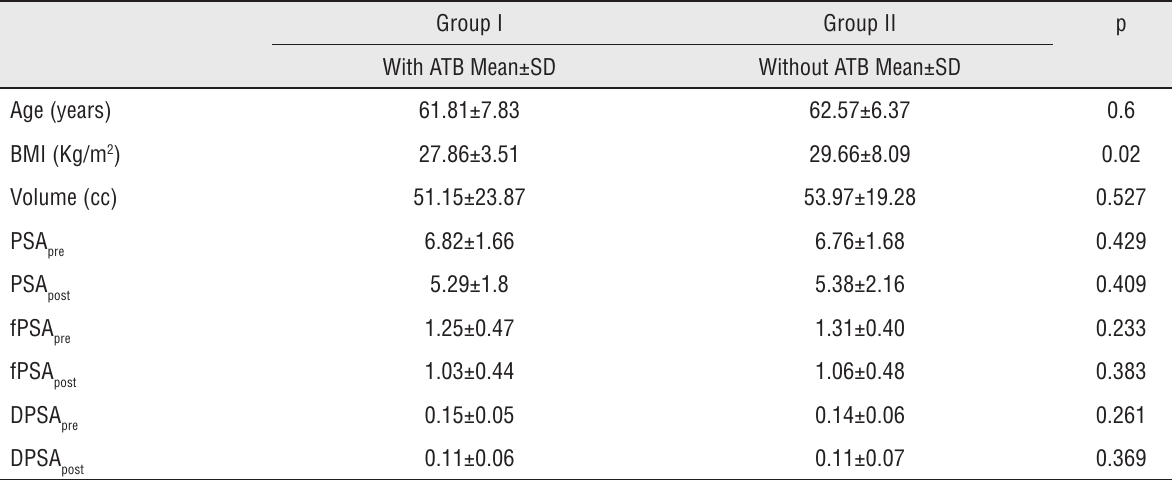
Table 1 - Comparison of initial values of the variables between groups. Group I Group II p With ATB Mean±SD Without ATB Mean±SD